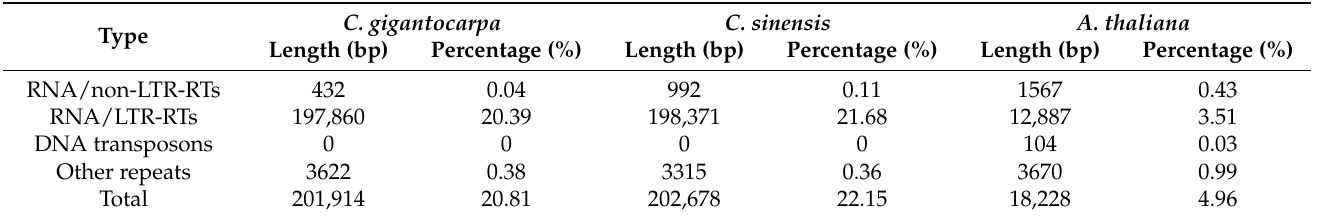
Table 1. Comparisons of repetitive sequence categories and contents of C. gigantocarpa , C. sinensis , and A. thaliana mitochondrial genome.